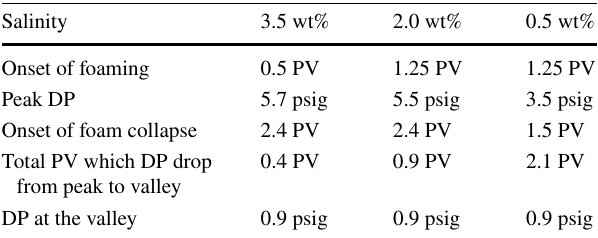
Table 5 Summary of sandpack flood result observations for the effect of salinity